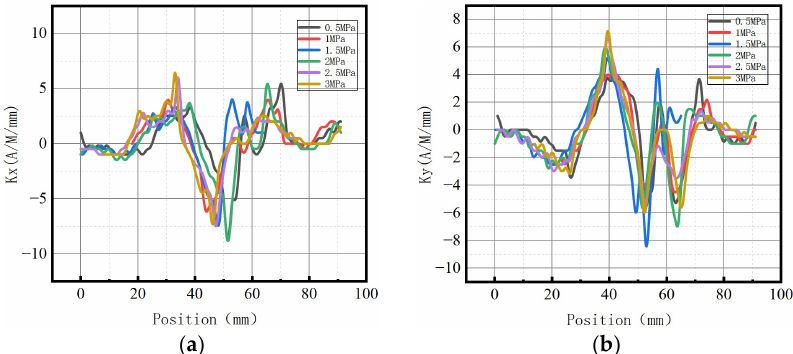
Figure 32. Variations of the magnetic field strength gradient K at weld crack under different internal pressures. ( a ) The axial gradient component Kx; ( b ) the radial gradient component Ky.